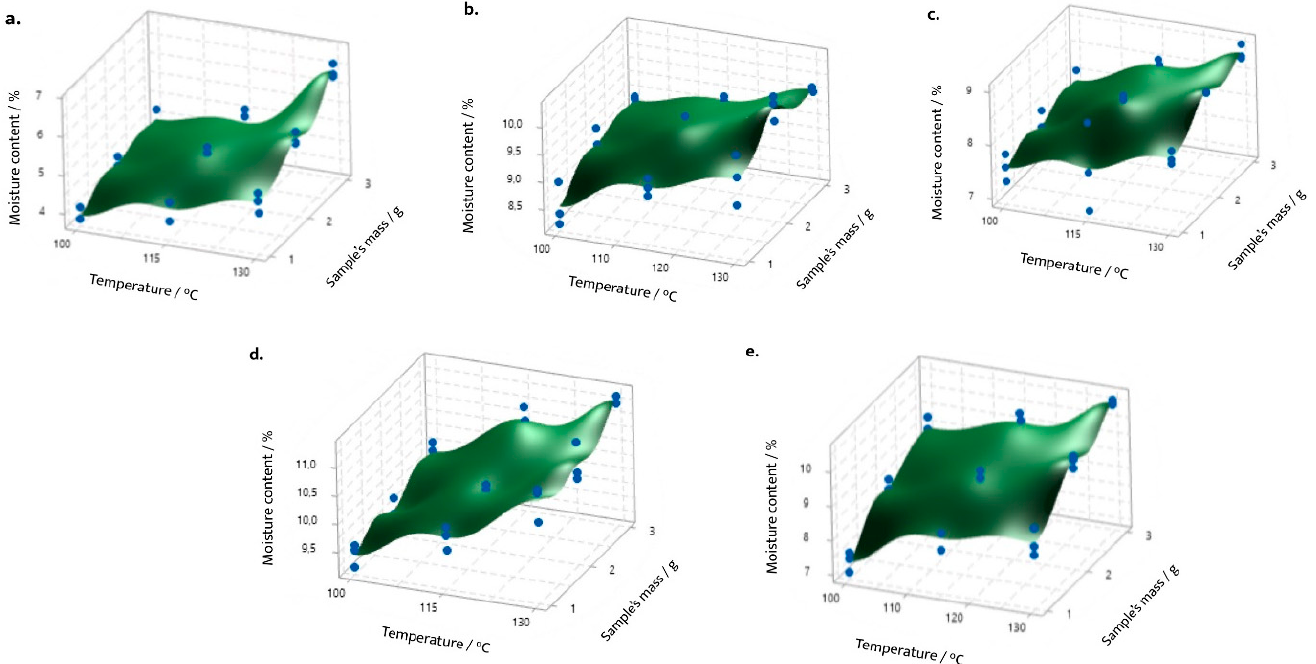
Figure 6. Example of a 3 2 full factorial design carried out in the Academy to evaluate the moisture content (%) in natural raw materials as a function of the balance’s temperature (°C) and sample’s mass (g): ( a ) Camelia sinensis , ( b ) Cassia fistula , ( c ) Chamaemelum nobile , ( d ) Lippia alba, and ( e ) Tilia platyphyllos . Reprinted with permission from Castillo, L. et al. Borneo Journal of Pharmacy , 3(1). Copyright